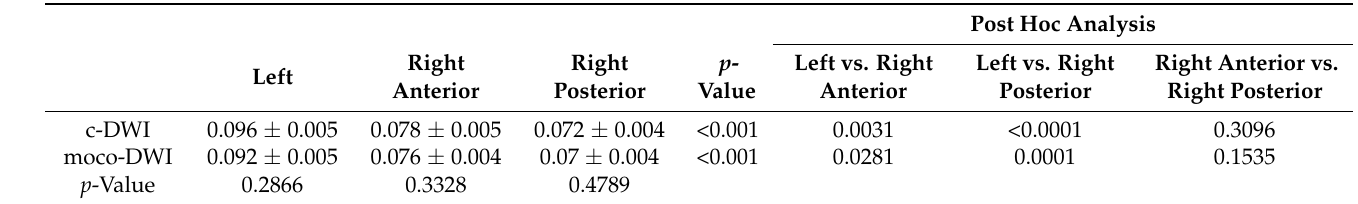
Table 4. Comparison of SD of ADC measurement in liver parenchyma between c-DWI and moco-DWI. Post Hoc Analysis p - Right Right Left vs. Right Left vs. Right Right Anterior vs. Left Anterior Posterior Value Anterior Posterior Right Posterior c-DWI <0.001 0.0031 <0.0001